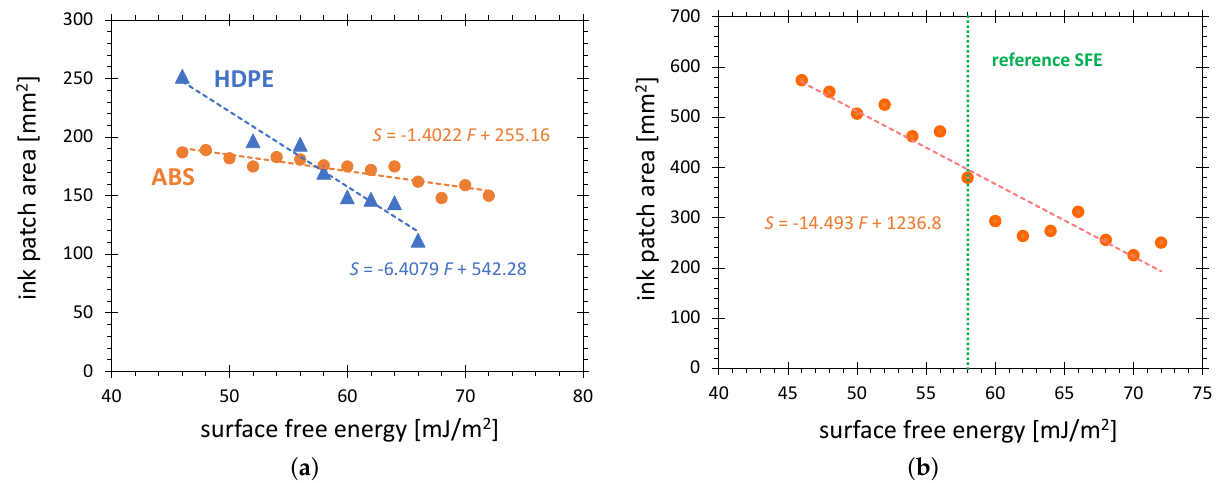
Figure 6. The visualized activation area on a substrate surface as a function of SFE calibration of the test ink. ( a ) Discharge configuration G was used with the treatment time of 20 s on HDPE and 10 s on ABS; ( b ) Discharge configuration C was used for 10 s treatment on HDPE.